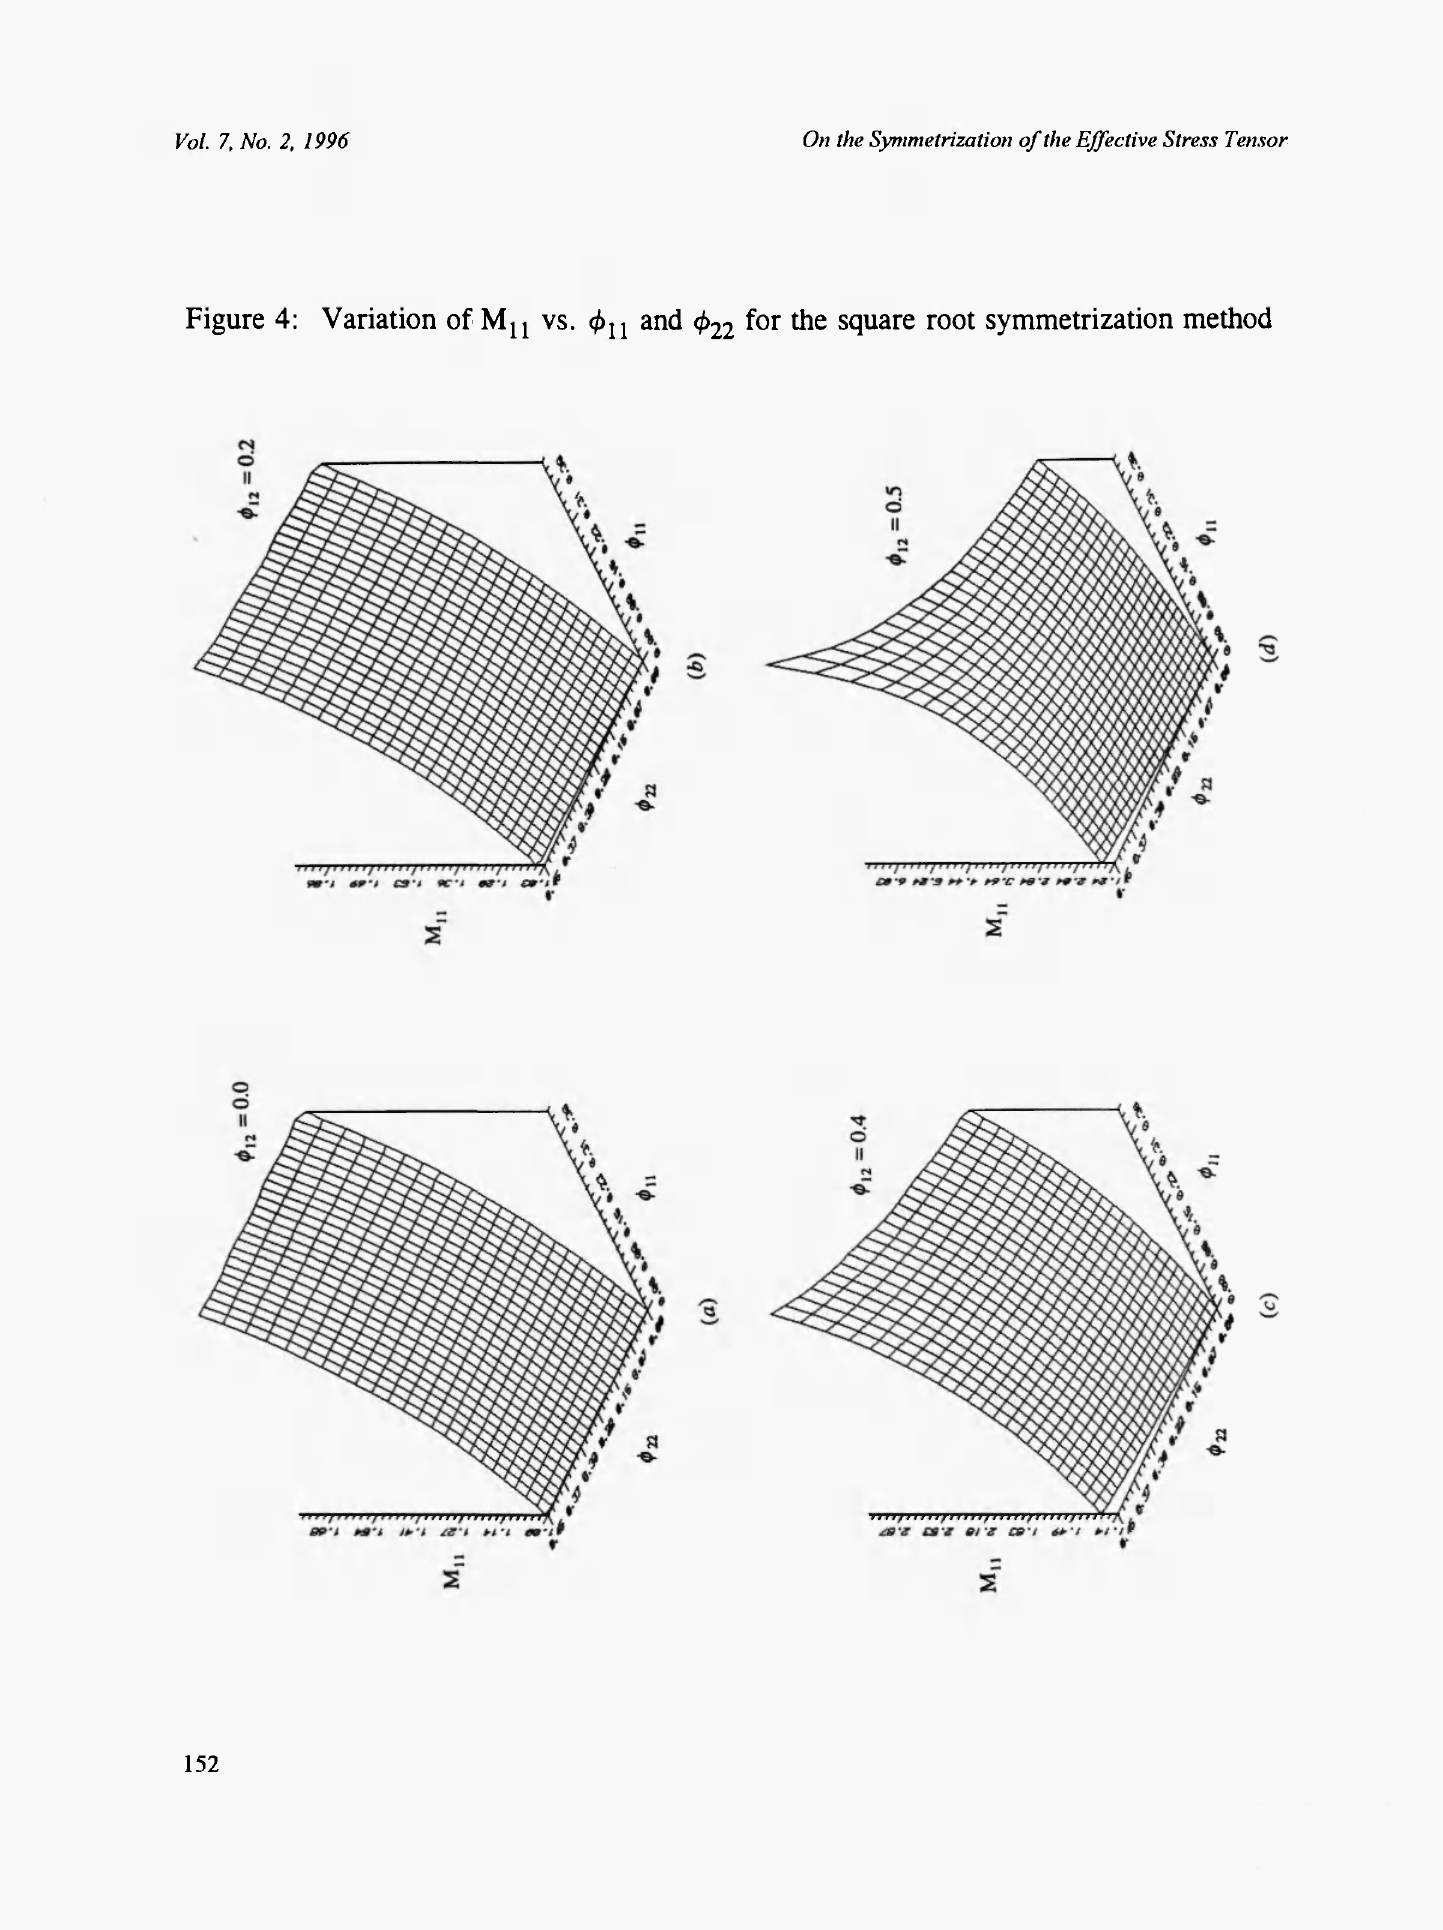
vs. φ and φ for the square root symmetrization n ΙΛ 22